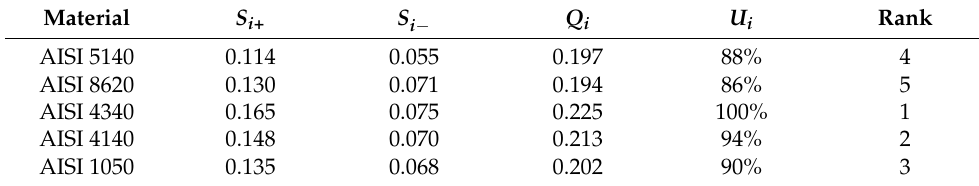
Table 16. COPRAS